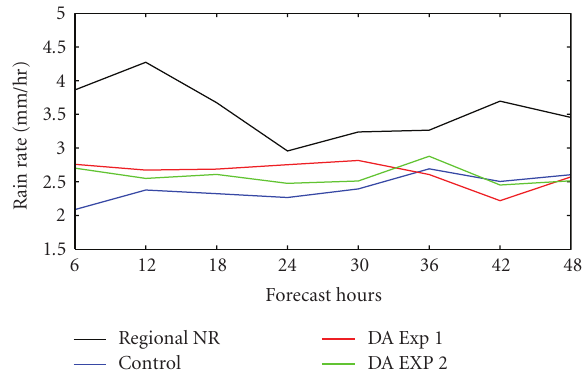
Figure 11: The time series of area-averaged rain rate (mm/hr) over the area with radius of 250 km around the storm center between 1200 UTC 01 and 0600 UTC 03 October 2005. (Black line: regional nature run; blue line: control run; red line: data assimilation Experiment 1; green line: data assimilation Experiment